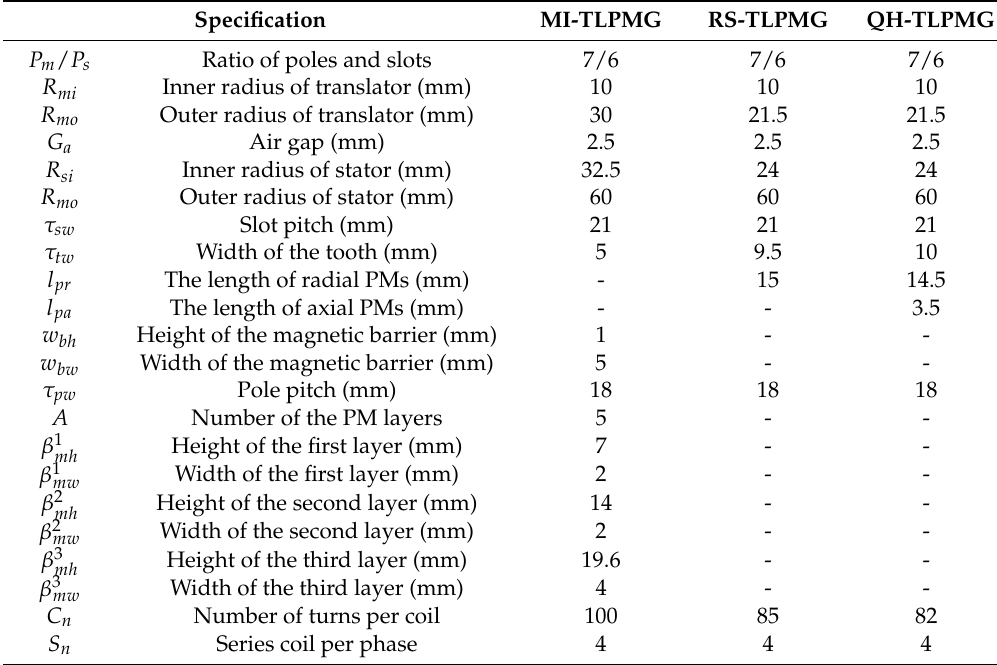
Table 1. Key specifications of the three different machines.